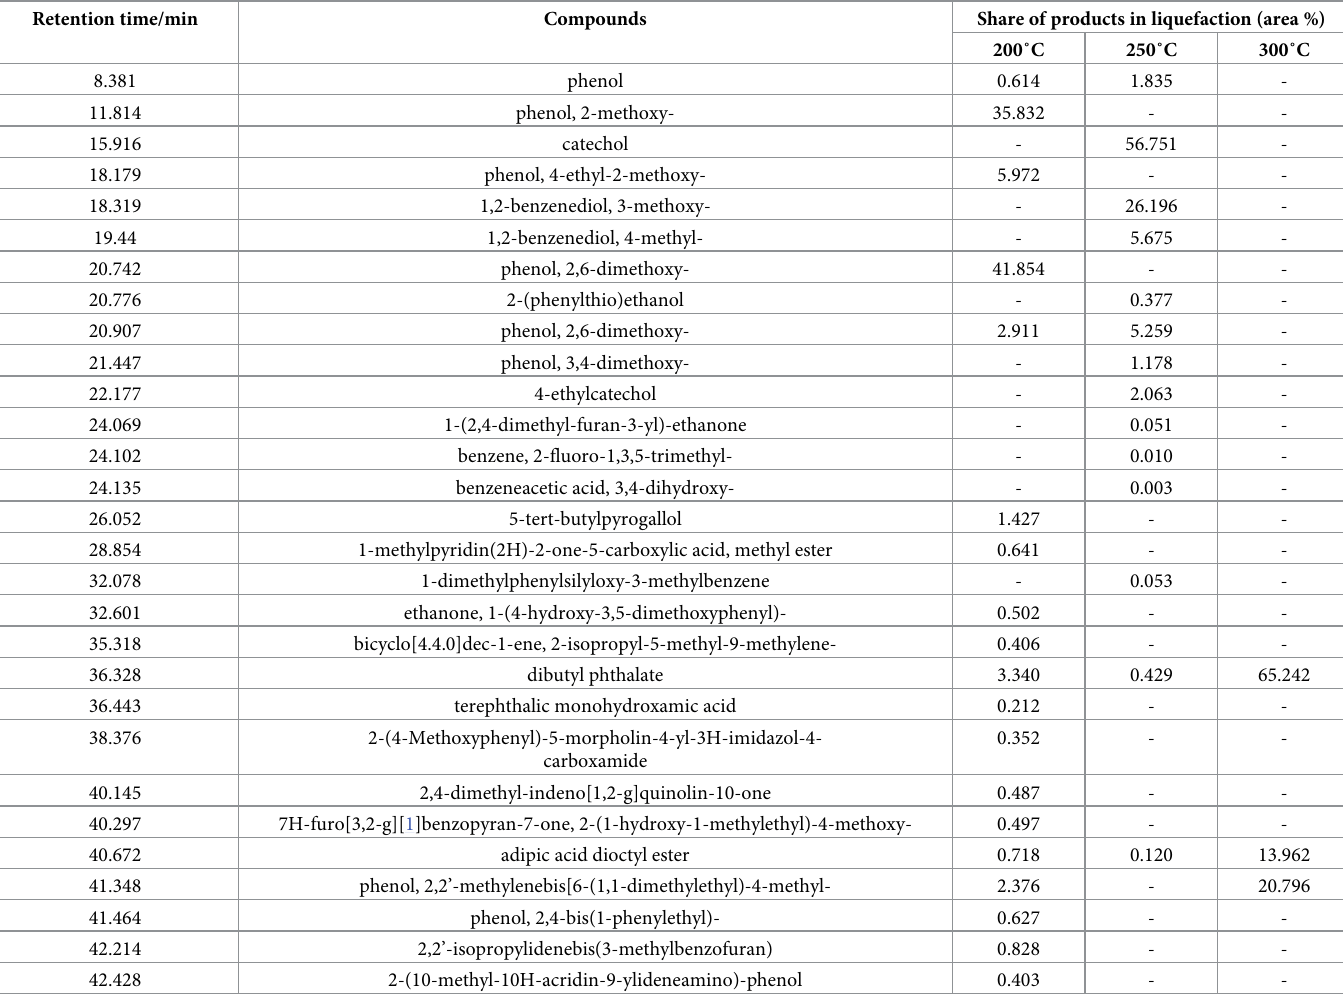
Table 4. Liquid organic products from HTC reactions of